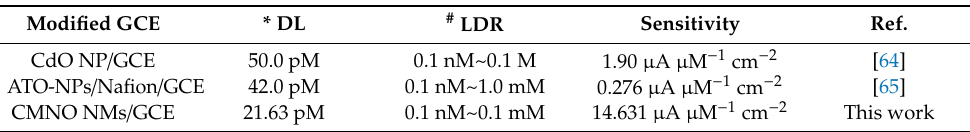
Table 1. Comparison of CMNO-fabricated sensor probe performances for the detection of CA based on di ff erent electrode fabrication by electrochemical